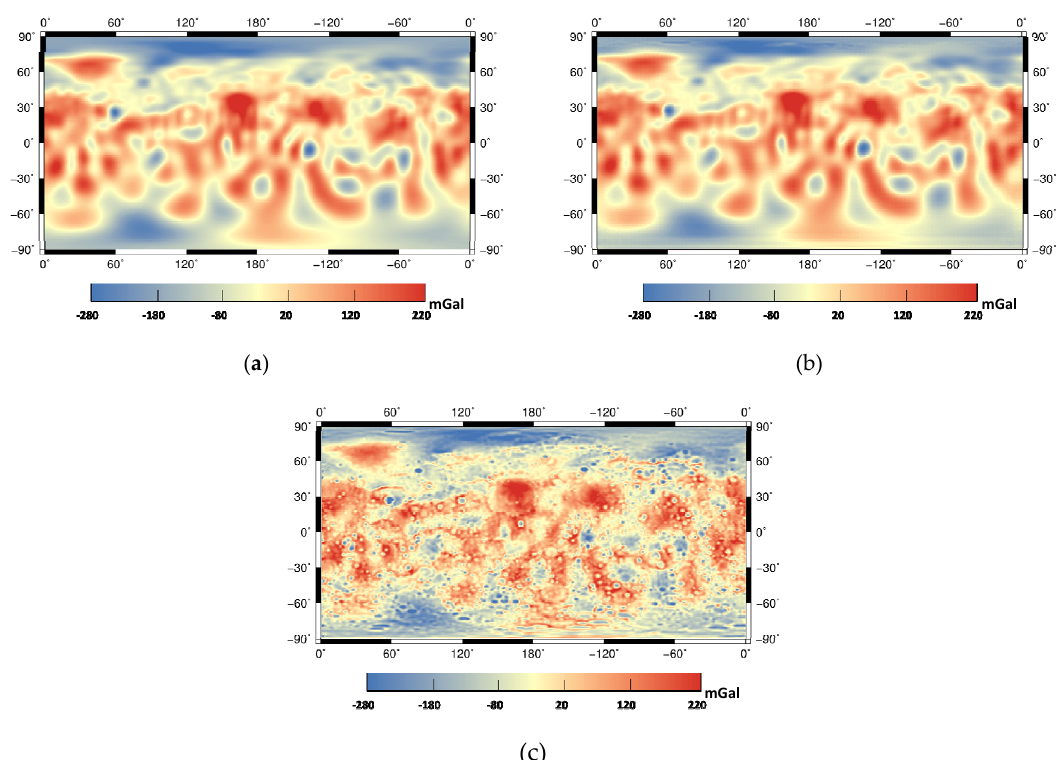
Figure 8. Visual comparison of 200-degree reconstructed spatial structure at × 4 scale of Mercury’s gravity data. ( a ) Bicubic 200 degree ( × 4); ( b ) Coarse output 200 degree ( × 4); ( c ) Fine output 200 degree ( × 4).